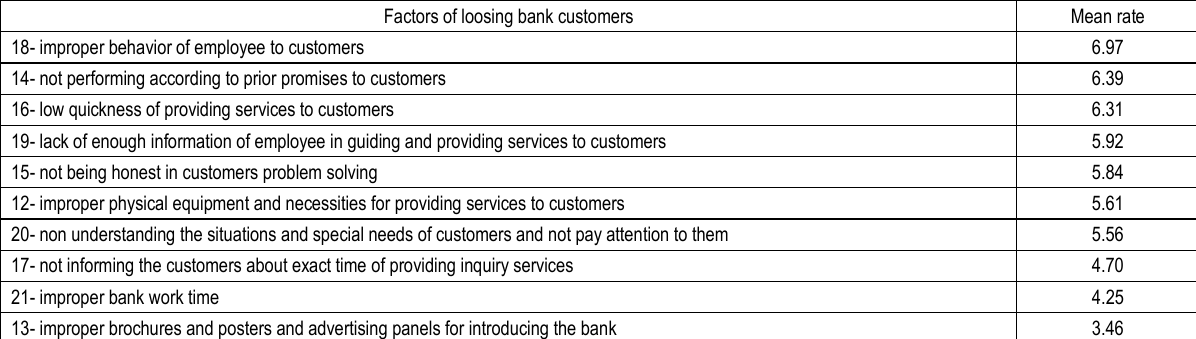
Table 20. Mean rate of most important factors of loosing bank customers based on priority